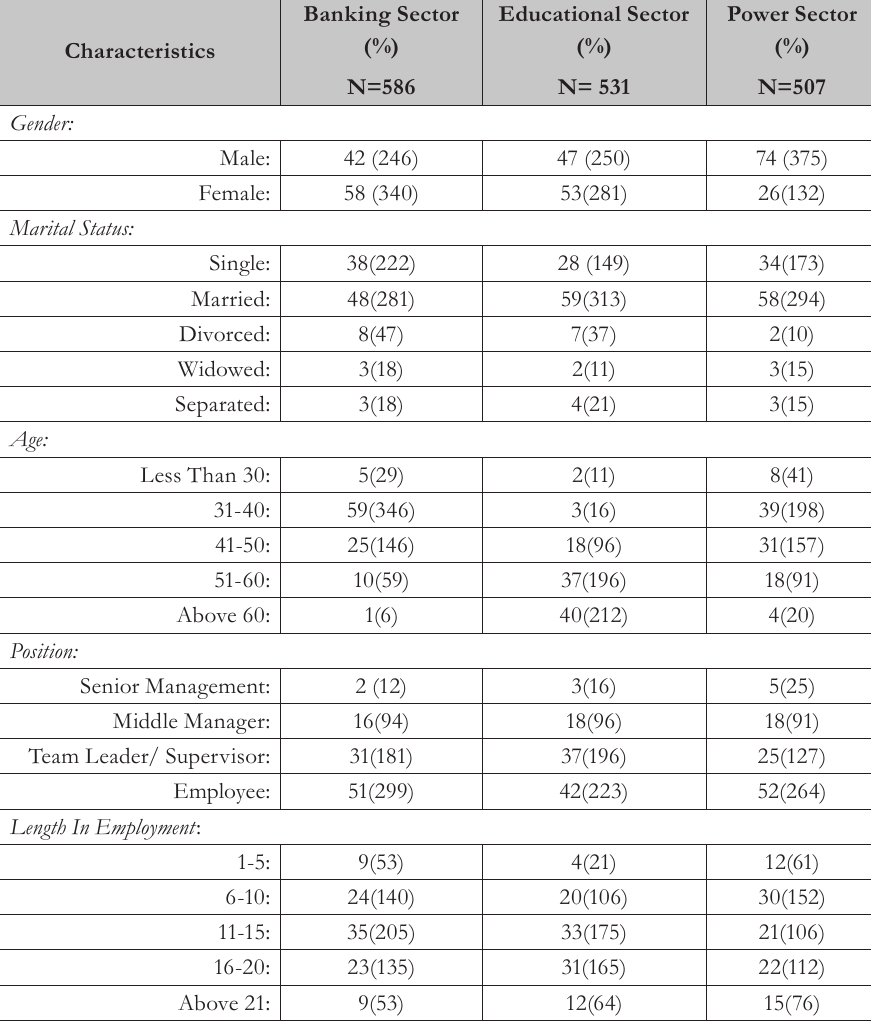
Tab. 1 - Demographic characteristics of participants. Source: Field Survey,